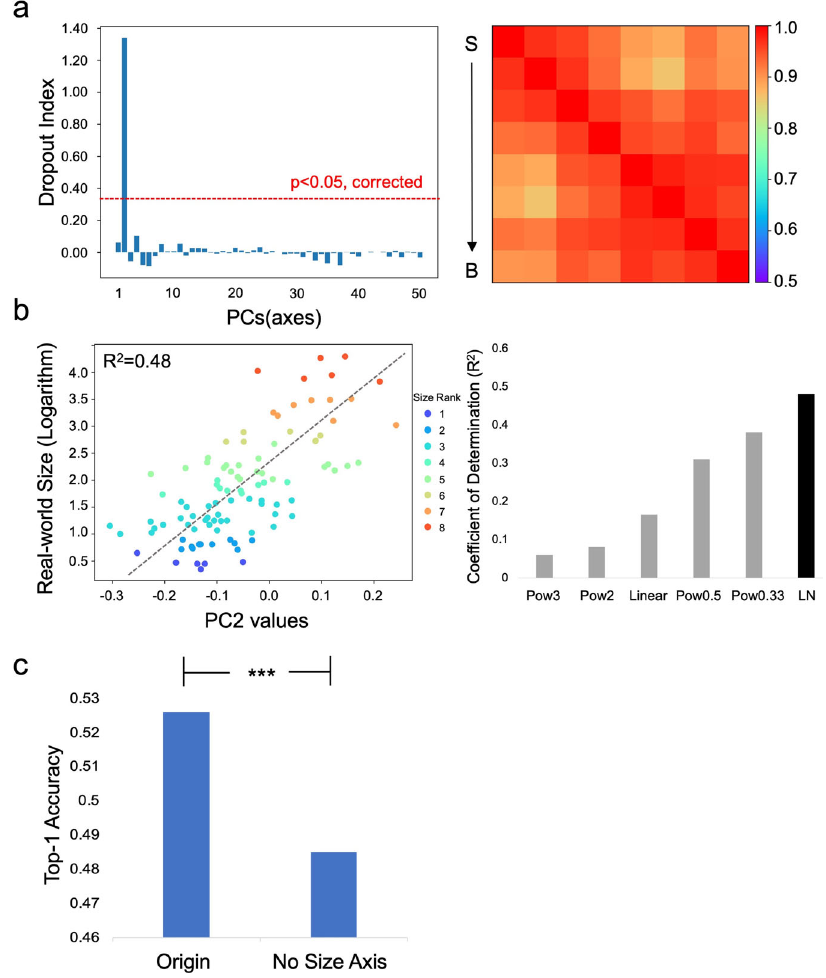
Fig. 2 The axis of object space for objects ’ real-world size. a Among all 50 PCs, only the removal of PC2 signi fi cantly reduced the correspondence between the RSM of Conv4 ’ s responses and that of the ideal observer (Left). This is demonstrated by the RSM of Conv4 ’ s residual responses after regressing out response variance aligned to PC2, which no longer showed sensitivity to objects ’ size (Right). b The mapping of objects ’ real-world size to PC2 was best described as a common logarithm function (left), among all functions tested (right). The color indicates size rank. c The removal of the response variance aligned to PC2 signi fi cantly impaired AlexNet ’ s performance on object recognition. S small objects, B big objects. Pow power, LN common